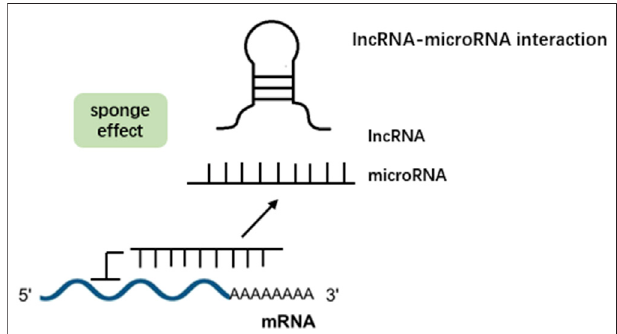
FIGURE1| LncRNAscanactasaspongeformicroRNAs.Bybindingto these microRNAs, they prevent microRNAs from binding to their target mRNAs, thereby abolishing post-transcriptional